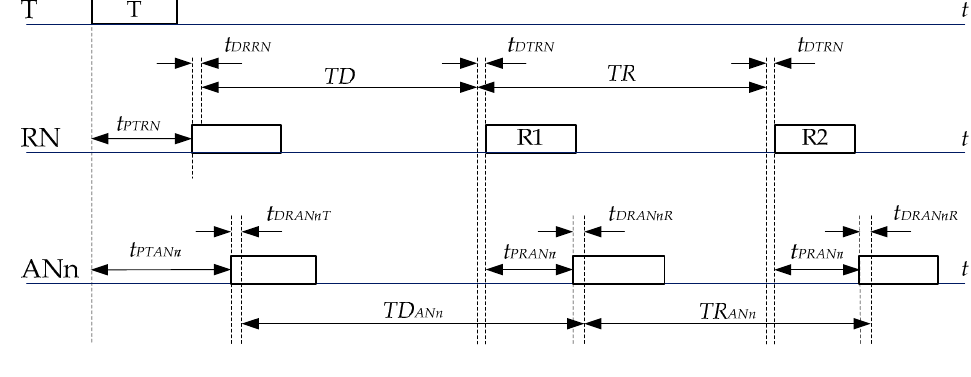
Figure 8. Exemplary transmission scheme.